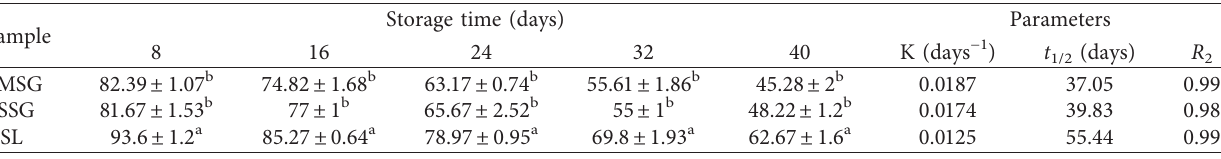
Table 2: Encapsulation efficiency, regression analysis, and half-life values of encapsulated powders produced with different wall materials during 40days storage at 30 ° C.